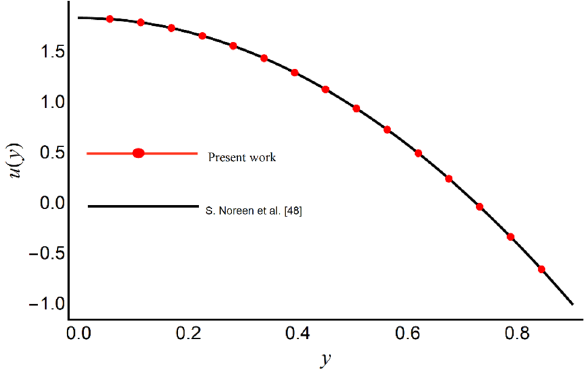
Figure 2. Comparison of the axial velocity profile of present work with the velocity distribution presented by S, Noreen et al. 48 .